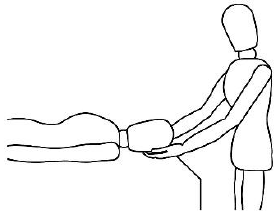
Figure 4. Calf support, ninth bilateral touch.